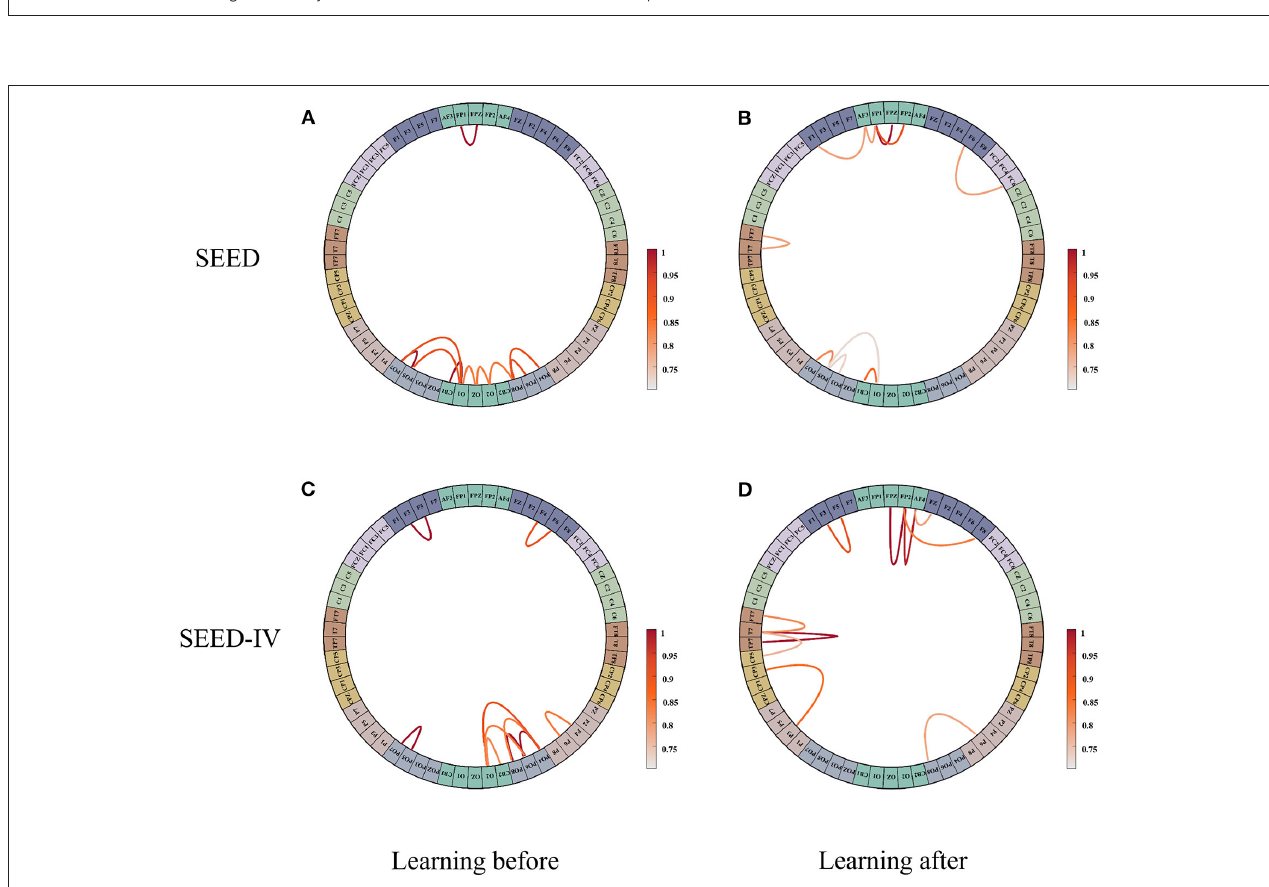
FIGURE 5 | The connection weights between the first 10 channels are selected from the initial adjacency matrix and the learned adjacency matrix. (A) is the initial adjacency matrix of the SEED data set, (B) is the adjacency matrix learned from SEED dataset. (C) is the initial adjacency matrix of the SEED-IV data set, (D) is the adjacency matrix learned from SEED-IV